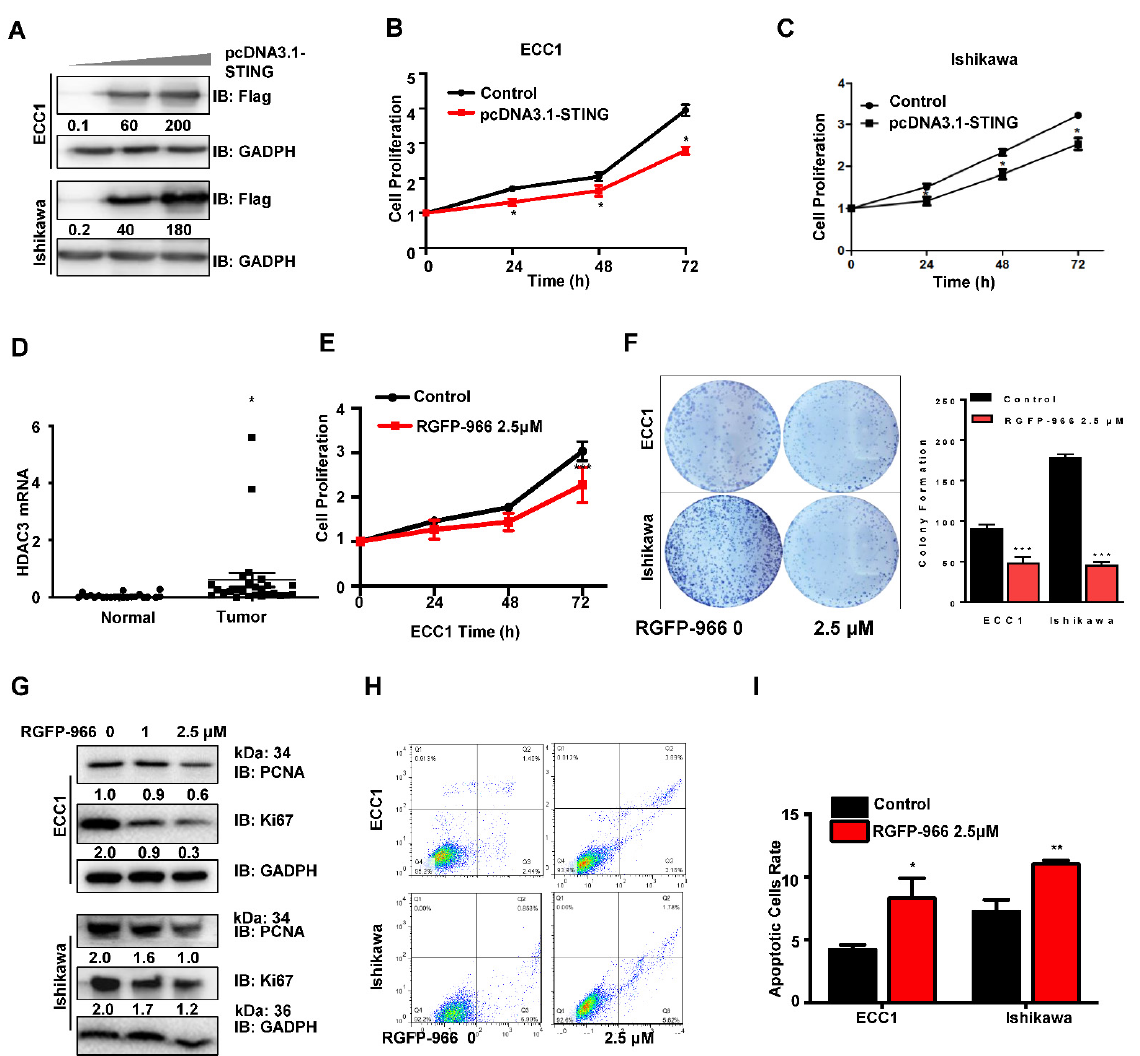
Figure 3. HDAC3-selective expression or inhibition governs the cell proliferation and apoptosis of endometrial carcinoma. ( A ) IB analysis of WCL derived from ECC1 and Ishikawa cells transfected with pcDNA3.1-STING constructs for 24 h. ( B , C ) CCK-8 analysis was used to detect the proliferation of ECC1 ( B ) and Ishikawa ( C ) cells transfected with pcDNA3.1-STING construct. ( D ) qPCR analysis of HDAC3 mRNA expression in EC tissues (n = 22) compared with normal tissues (n = 27). ( E ) CCK8 analysis of ECC1 cells treated with 2.5 μ M RGFP-966 for 0–72 h. ( F ) Colony formation assay of ECC1 and Ishikawa cells treated with 2.5 μ M RGFP-966. ( G ) IB analysis of WCL derived from ECC1 and Ishikawa cells treated with indicated doses of RGFP-966 for 48 h. ( H ) Flow cytometry analysis of ECC1 and Ishikawa cells were transfected with 2.5 µ M RGFP-966 for 48 h. ( I ) Quantification of apoptosis cells in Figure 3H. The cell-based experiments were repeated at least three times, and representative results are shown as mean ± SD. Two-way ANOVA analyses were used to calculate the p -value. * p < 0.05, ** p < 0.001, *** p < 0.0005 significantly different from control. Original image of Western blot can be found in File